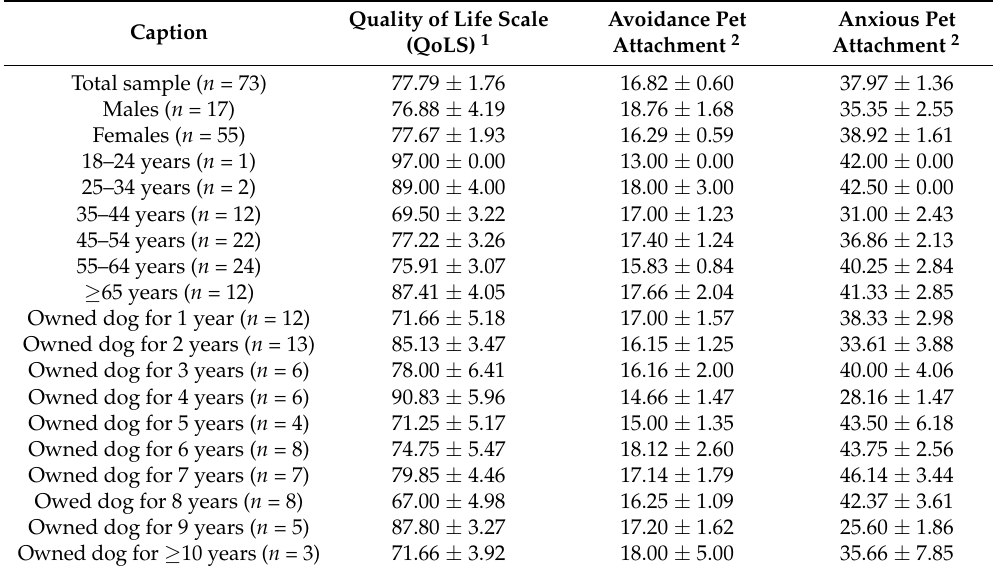
Table 1. Descriptive statistics (means ± standard error means) for scores of quality of life, avoidance pet attachment and anxious pet attachment.